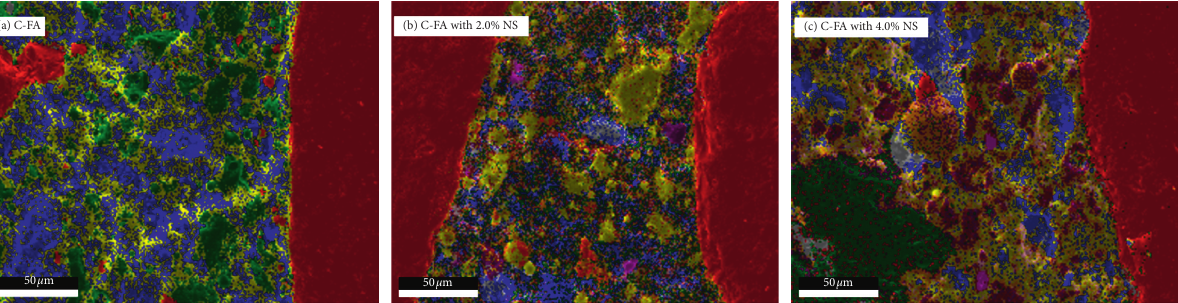
Figure 8: SEM-EDS images of the mortar. Table 4: Phase distribution in